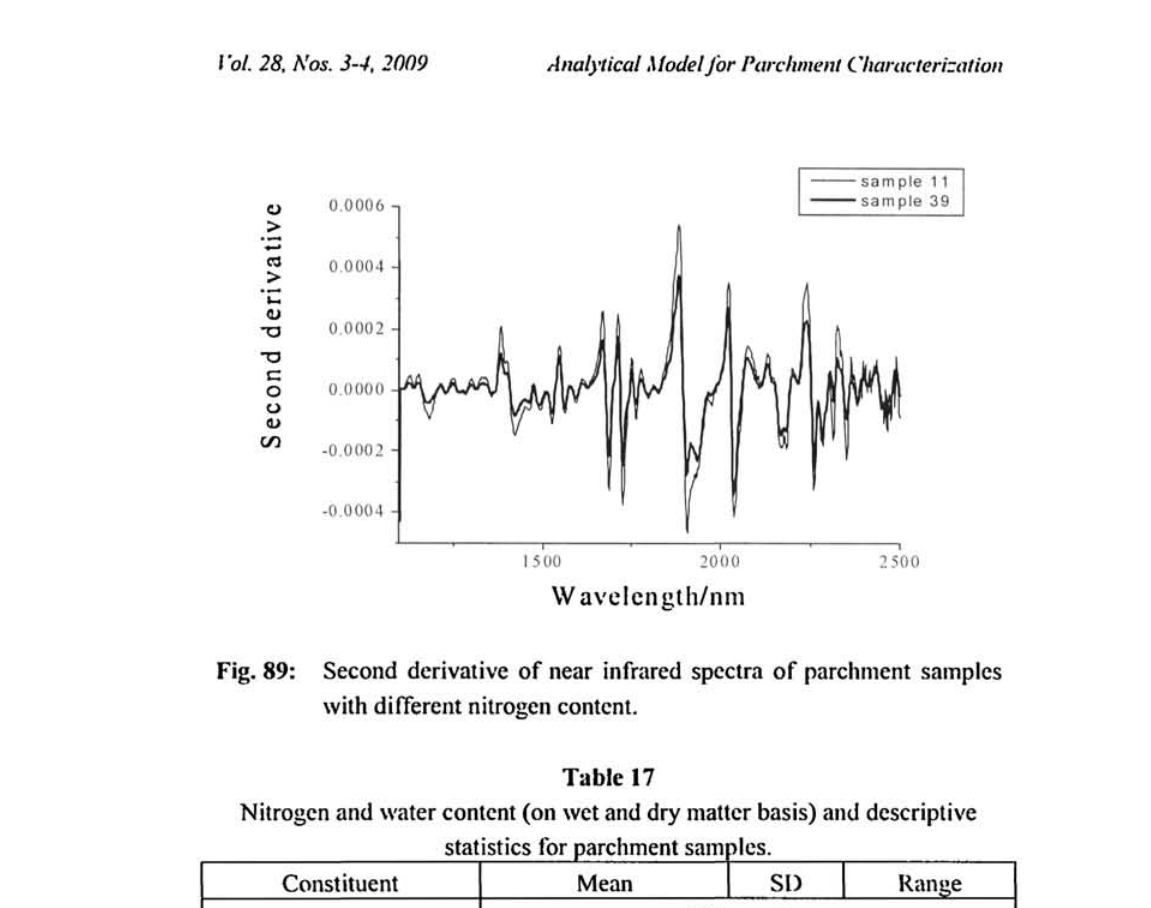
Nitrogen and water content (on wet and dry matter basis) and descriptive statistics for parchment